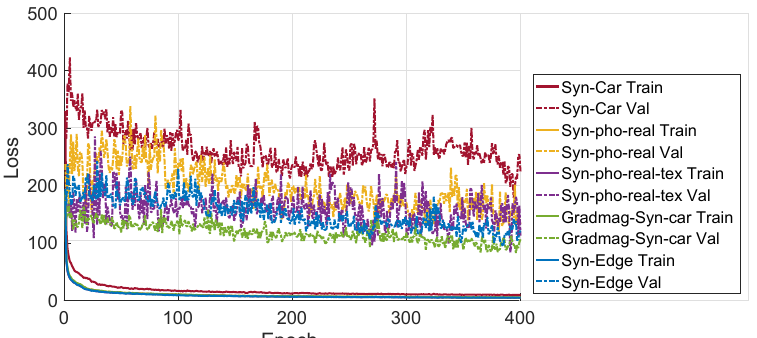
Figure 13. The training and validation losses for the networks fine-tuned with synthetic image sequences and validated with real images sequences, having a window size of 10.